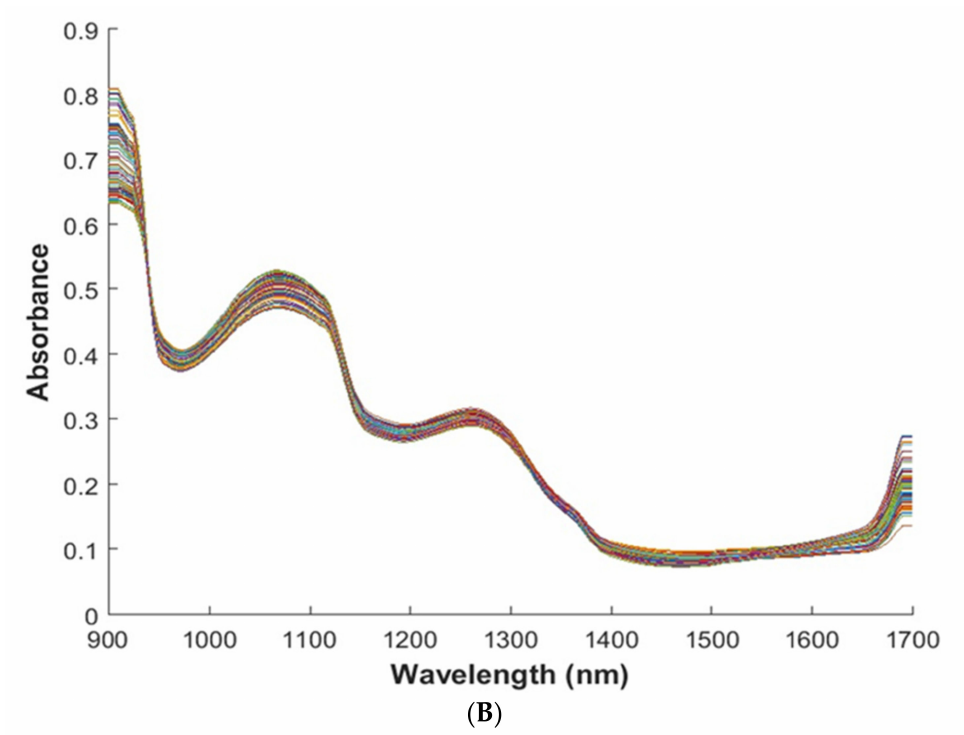
Figure 2. Pre-processed absorbance spectra of goji berry at the wavelength range of ( A ) VIS-NIR 400–1000 nm and ( B ) NIR 900–1700 nm.